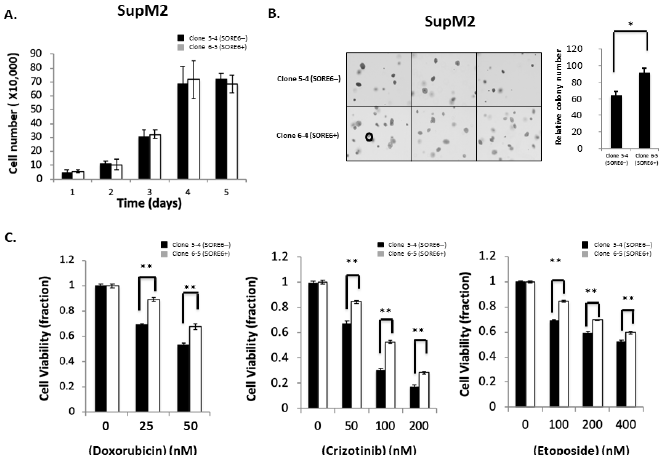
Figure 4. Cell growth, colony formation, and response to therapeutic agents in SORE6 - and SORE6+clones. (A) Cell growth of 5-4 (SupM2 SORE6 - ) and 6-5 (SupM2 SORE6+) clones over the course of 5 days. (B) Soft agar colony formation of SORE6 - and SORE6+ subsets in SupM2 clones for 10 days. The circle on the bottom-left panel marks the cutoff for a colony to be counted. Triplicate experiments were performed. Experiments were repeated in two single-cell clones. The right panel showed the relative colony numbers in SupM2 cells. Results are mean SEM, * p < 0.05. (C). SupM2 SORE6 - and SORE6 + cells after treatment with doxorubicin, crizotinib, and etoposide at the indicated concentrations for 48 h at 5% FBS. Results shown are representative of three independent experiments. ** p < 0.01.